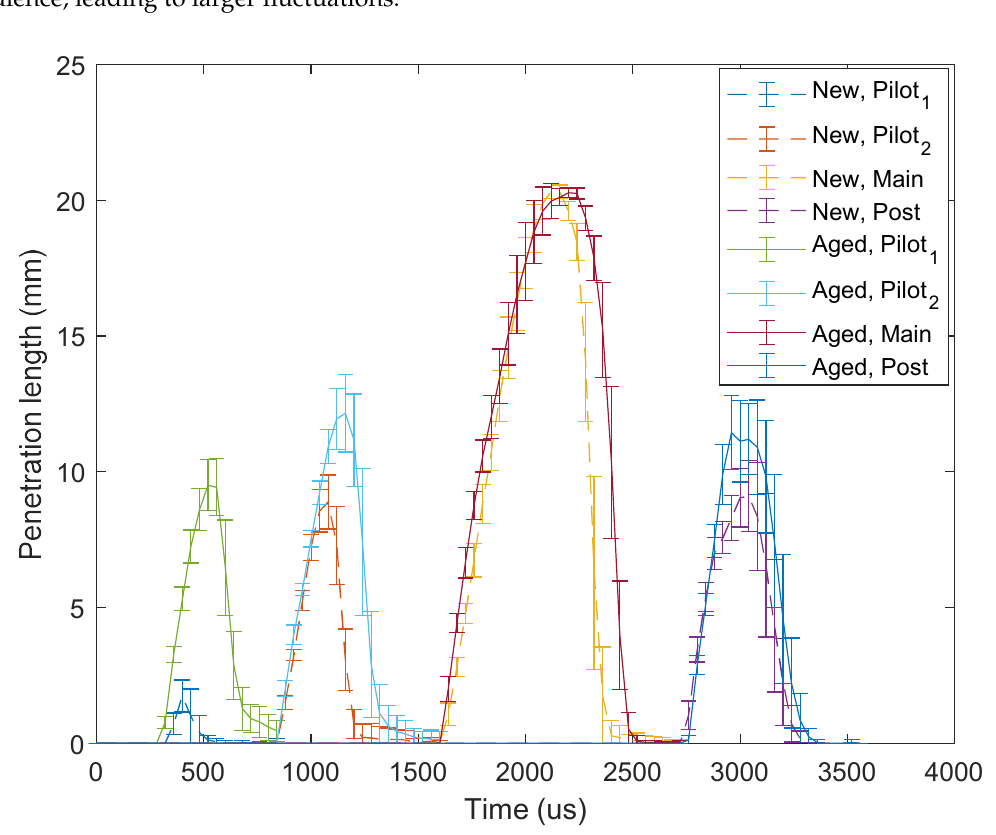
Figure 12. Spray penetration at medium load using new and aged injectors.